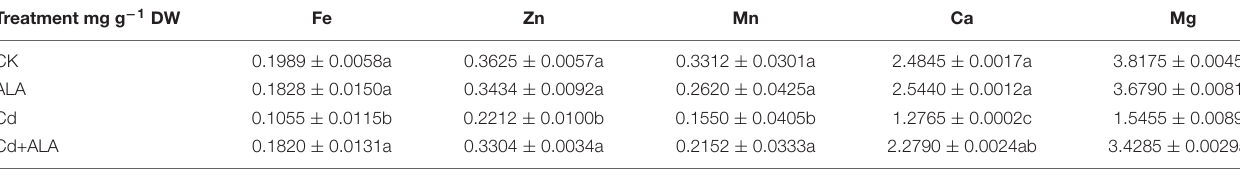
TABLE 2 | Effects of ALA on the concentrations of Fe 2 + , Zn 2 + , Mn 2 + , Ca 2 + , and Mg 2 + in leaves under Cd stress.